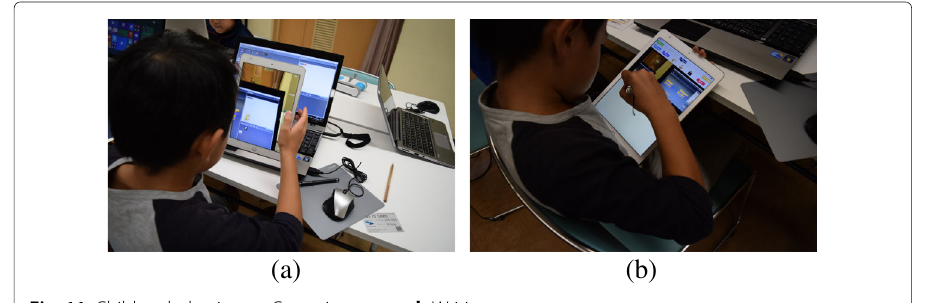
Fig. 11 Children behaviour. a Capturing screen. b Writing a